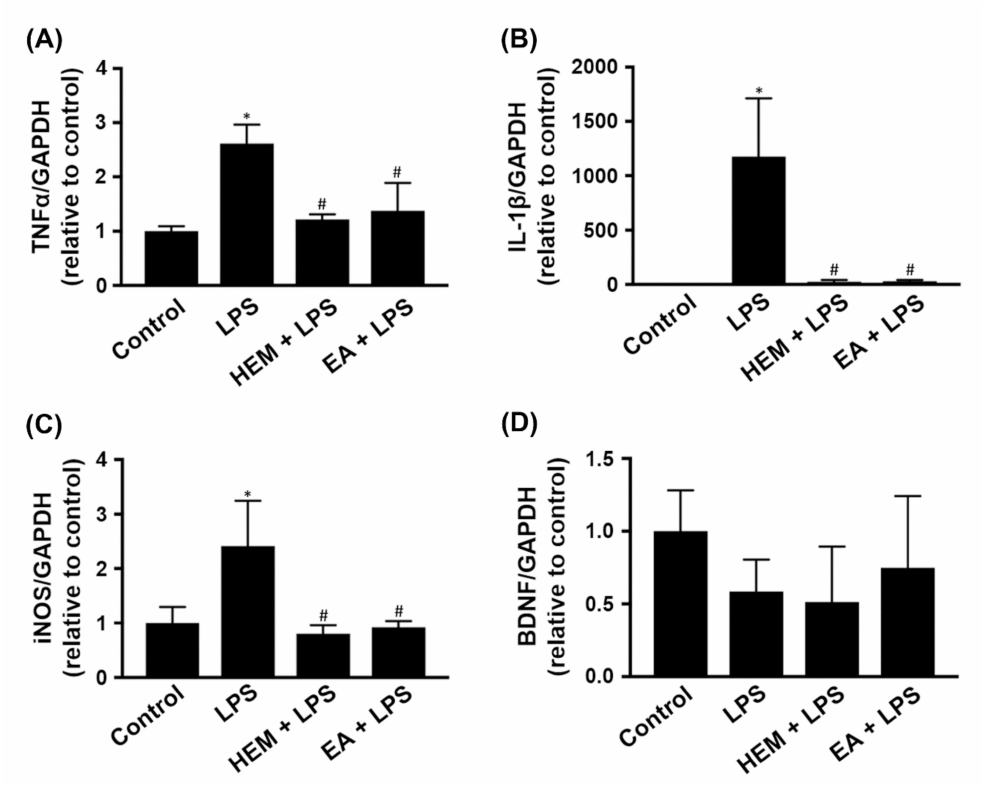
Figure 8. HEM or EA treatment downregulates pro-neuroinflammatory mediators in the midbrain of LPS-induced PD model rats. Rats were sacrificed after the amphetamine-induced rotation test (as shown in Figure 1). ( A – D ) Real-time RT-PCR analysis of proinflammatory cytokine (TNF- α and IL-1 β ), anti-neuroinflammatory factor (BDNF) and proinflammatory enzyme (iNOS) expression in the midbrains of rats. The data are expressed as fold changes relative to the control rats. The results are expressed as the mean ± SD. * p < 0.05 compared to the control group, # p < 0.05 compared to the LPS